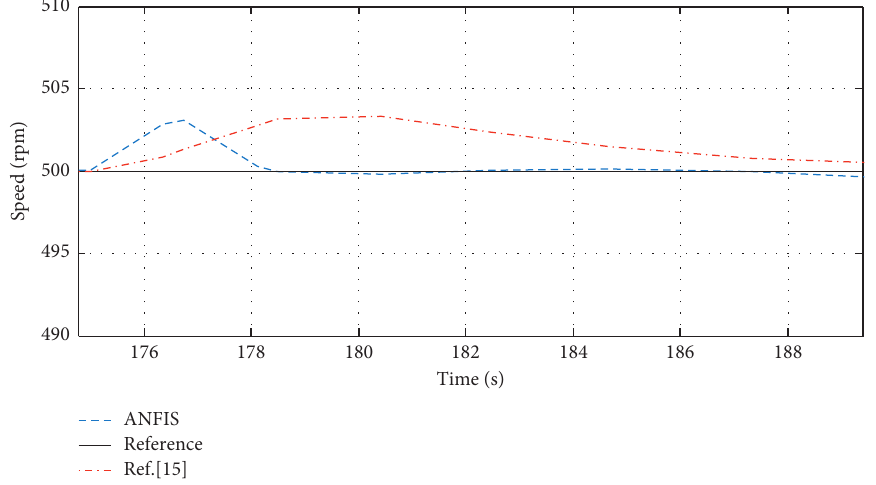
Figure 23: Magnification of Figure 21 at t �